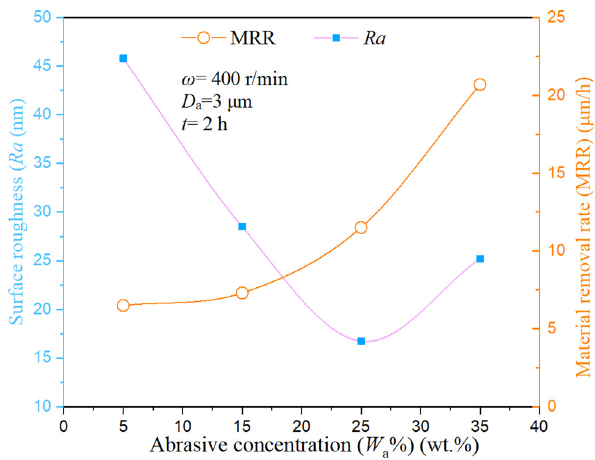
Figure 7: E ff ect of Al 2 O 3 concentration on polishing data of Ra and MRR.